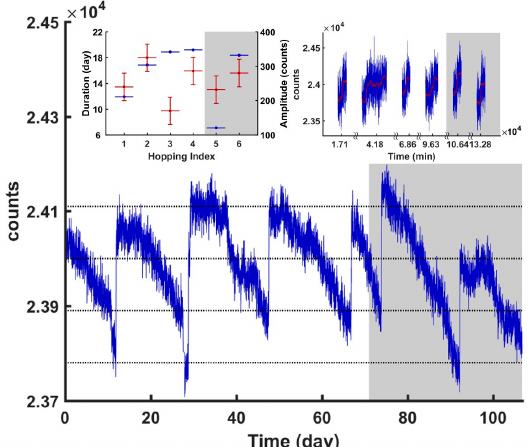
Figure 4. Seven Sisyphus cycles of superradiant Rayleigh scattering generated by a 2.5-mCi 137 Cs source at the position (0.3 cm, 90 ° ) in the first long-term monitoring experiment begun on 1 August 2016 (day 0), the raw data of which are given in Figure S1 of the Supplementary information. The time sequence of data was γ counts per minute, while the presentation incorporates hourly smoothing (61 data points). Four horizontal lines indicate the potential quantization. Air conditioners were turned off after day 71, indicated by the gray area. Inset diagrams show the mode hopping periods (blue), the hopping amplitudes (red) and the raw + smoothed data (blue + red) of the Sisyphus falls.